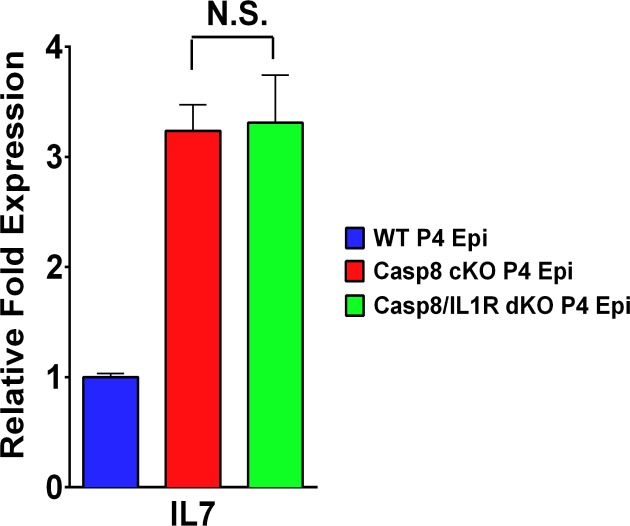
IL7 expression from caspase 8-deficient epidermis is not affected by IL-1α qPCR measurements of levels of IL-7 expression by keratinocytes.Data are the fold difference ± SEM of three samples per genotype analyzed in triplicate. The p-values comparing C8CKO and C8/IL1R dKO are not statistically significant (N.S.).